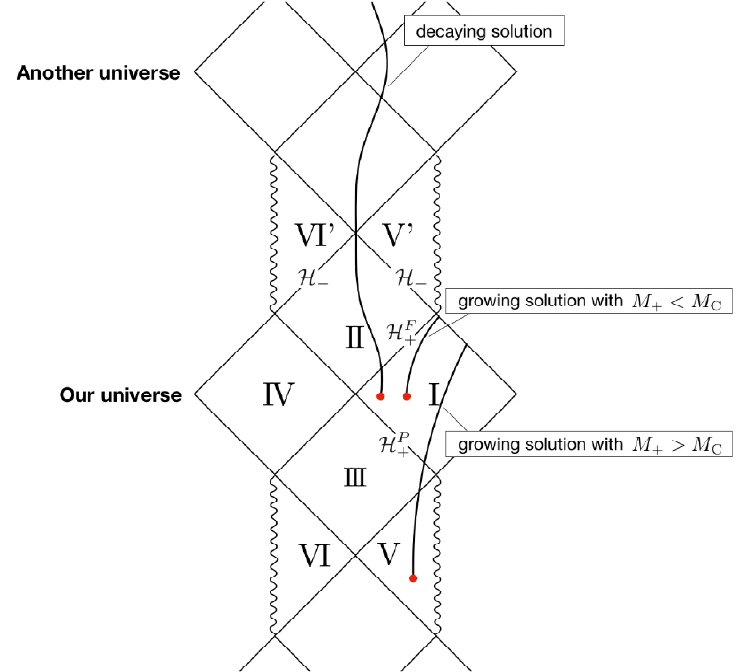
Figure 8 . The trajectories of the three solutions on the Penrose diagram of Kerr spacetime (black solid lines). The red points show the nucleation points of the vacuum bubbles. Only the growing bubble with M + (cid:20) M C is a physically meaningful solution. H F outer horizon and H (cid:0) is the inner